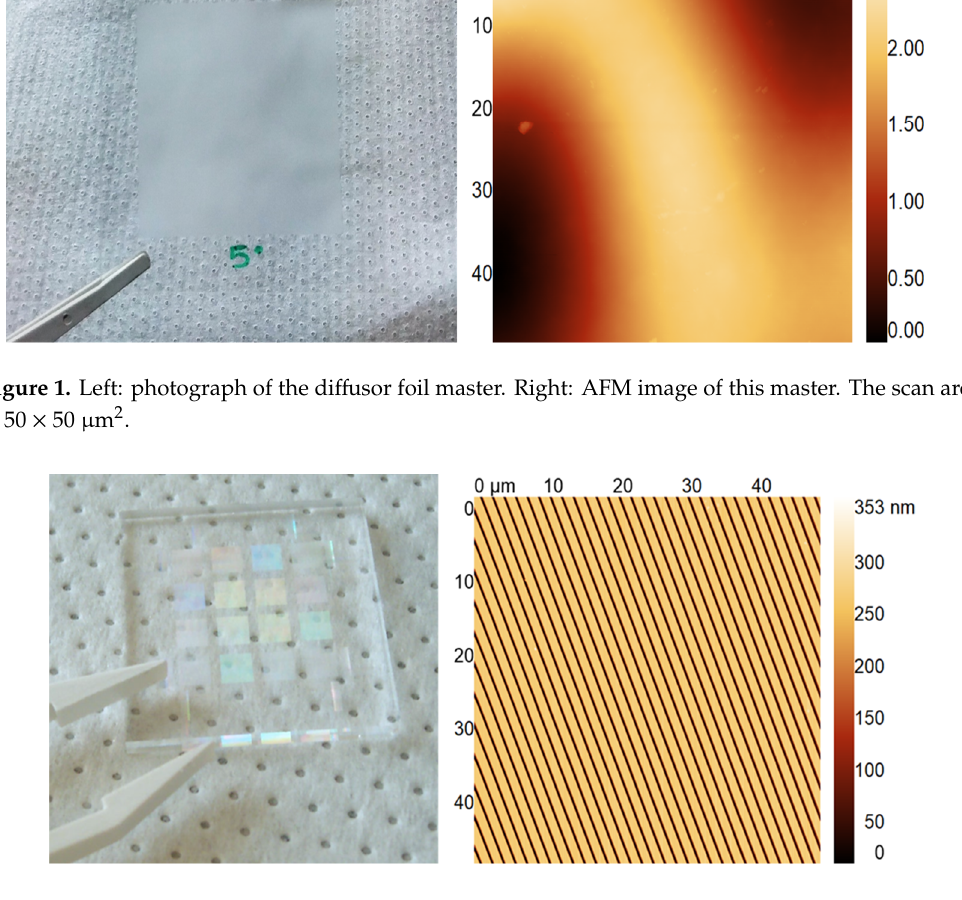
Figure 2. Left: photograph of the grating master. Right: AFM image of this master.